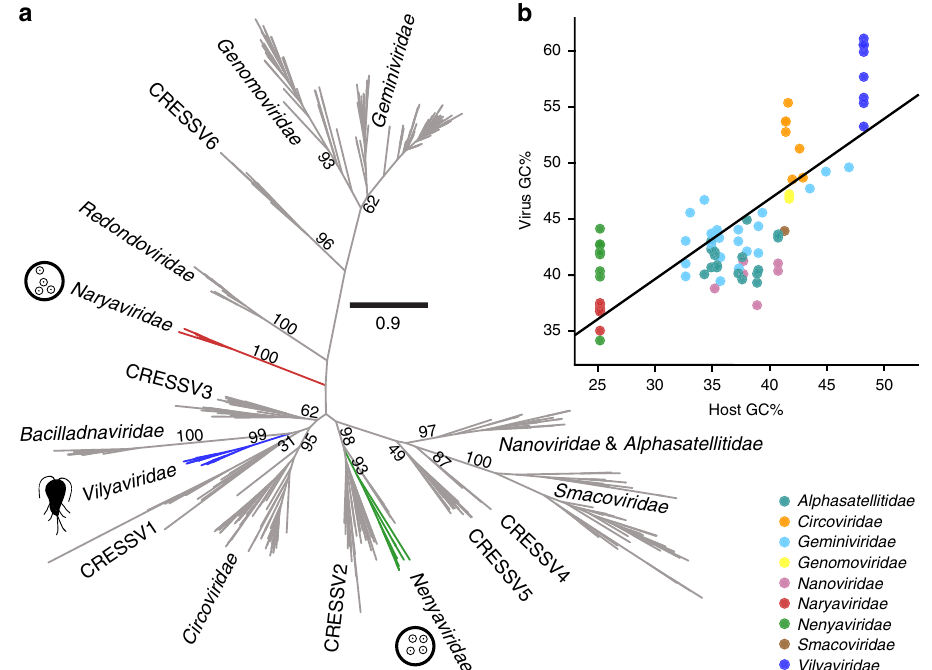
Fig. 2 Parasite-infecting CRESS virus genomes are distinct from known CRESS diversity. a Phylogenetic maximum-likelihood tree of the Rep protein, scale bar refers to amino acid substitutions per site, numerical values represent bootstrap support of major nodes. The Naryaviridae , Nenyaviridae , and Vilyaviridae contain endogenous viral element sequences extracted from host genomes, respective pictograms of Entamoeba (tetranucleate cyst stage) and Giardia ( fl agellated trophozoite stage) are shown to indicate this. Five public viral genomes were also found to cluster within these families (MG571899.1, KU043415.1, MH617639.1, KY487991.1 and LC406405.1). b Virus GC-content positively correlates with host GC-content (linear regression, n = 79 biologically independent viral genome sequences, r 2 = 0.58, p =